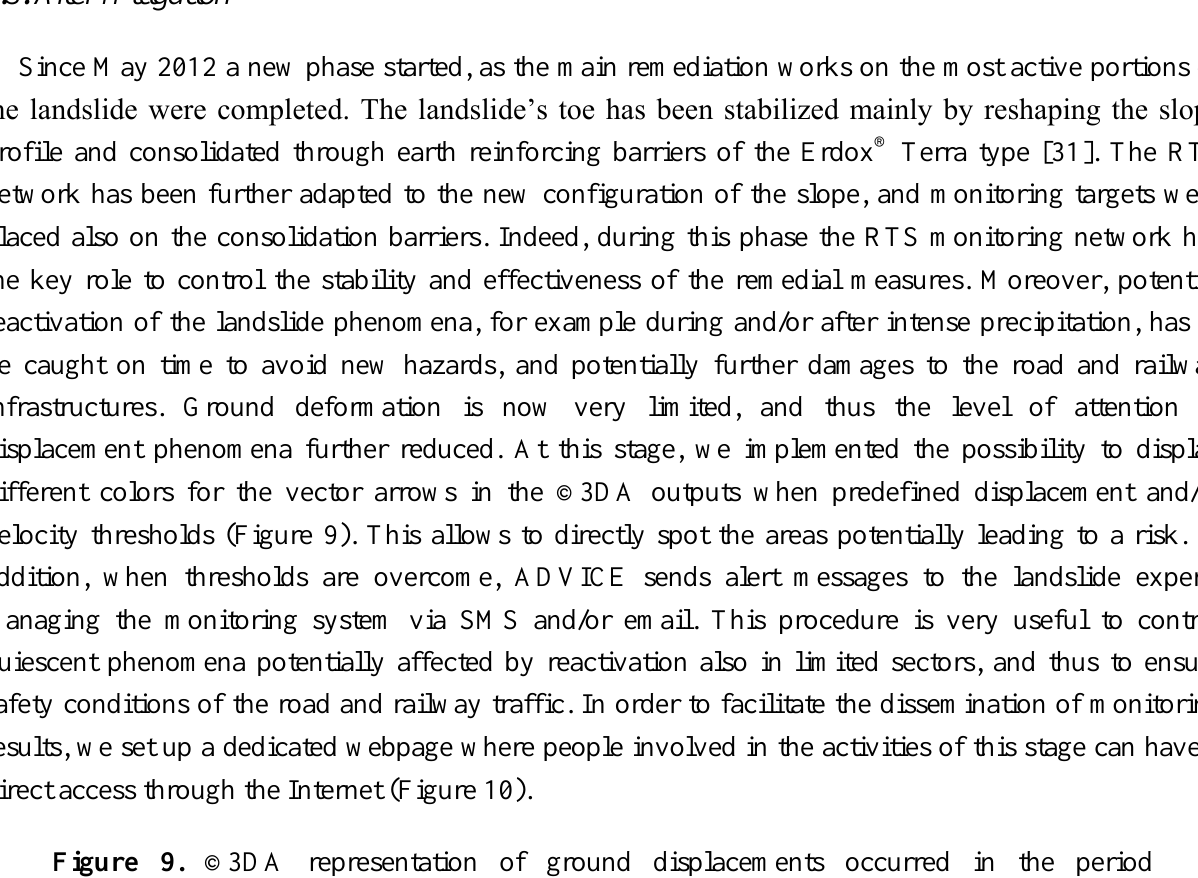
Figure 9. ©3DA representation of ground displacements occurred in the period 10–17 March 2013 with indications of targets that overcome predefined warning (yellow) and alarm (red) surface velocity thresholds. This reactivation occurred after a rain precipitation of about 50 mm within one week. Note the targets installed on the earth reinforcing barriers, marked with